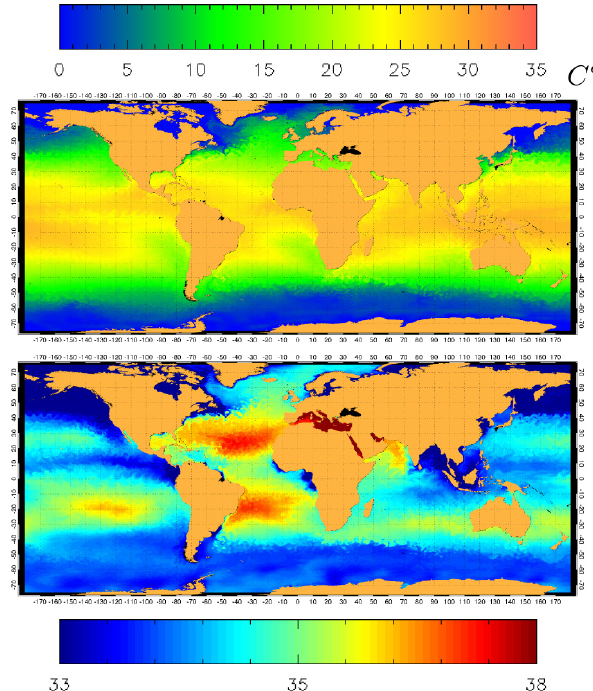
Fig. 1. OFES output for 1 January 1990. Top: SST map. Bottom: